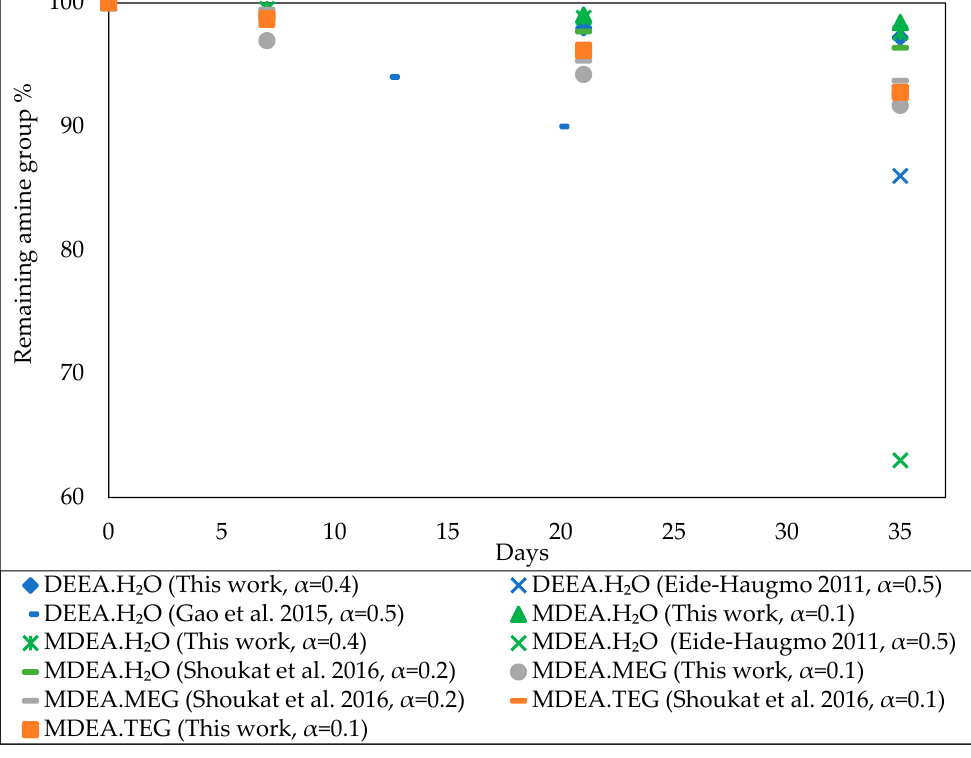
Figure 2. Comparison with the literature in terms of the remaining amine group concentration in 30 wt.% amine–H 2 O solutions (Eide-Haugmo 2011 [35], Gao et al. 2015 [39], Shoukat et al. 2016 [10]).